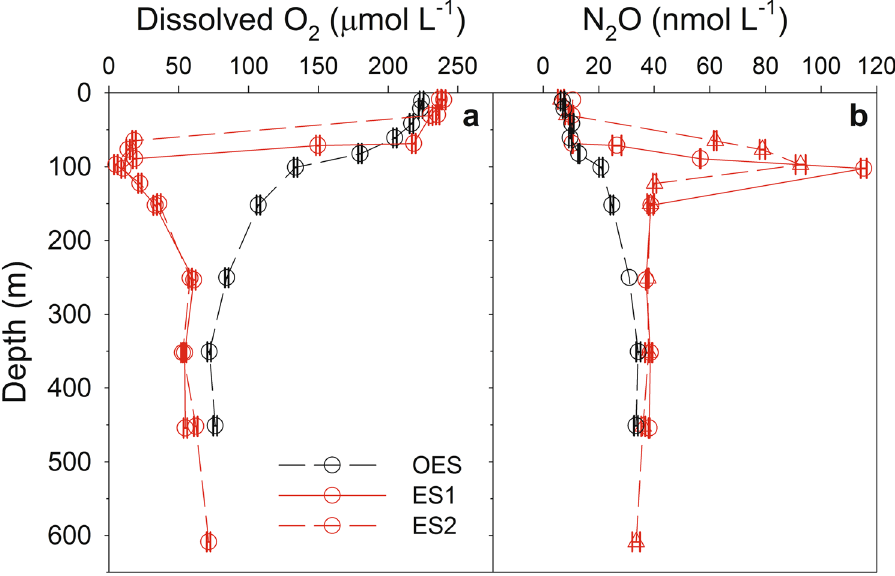
Figure 2. Vertical distributions of dissolved oxygen and N 2 O concentrations at the out-of-eddy station (OES), and at eddy stations 1 and 2 (ES1 and ES2, respectively). ( a ) Discrete depth dissolved oxygen (DO) concentrations measured with the CTD-DO sensor at each of our sampling depths. The error bars represent the average propagation of error associated with our DO measurements (see Methods section). ( b ) Discrete depth N 2 O concentrations. The error bars represent the standard deviation of duplicate N 2 O concentration measurements. Due to the loss of duplicated samples, standard deviations are not reported for 10 m depth at ES1, and 250 m depth at OES.